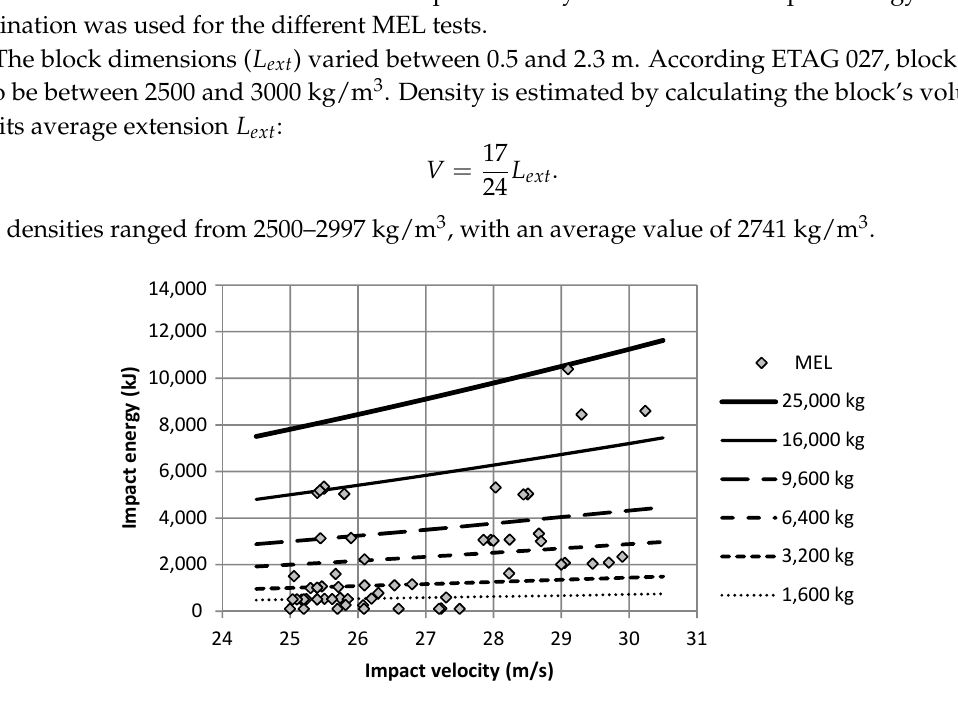
Figure 5. Measured impact velocities used to obtain the target impact energies for MEL tests.